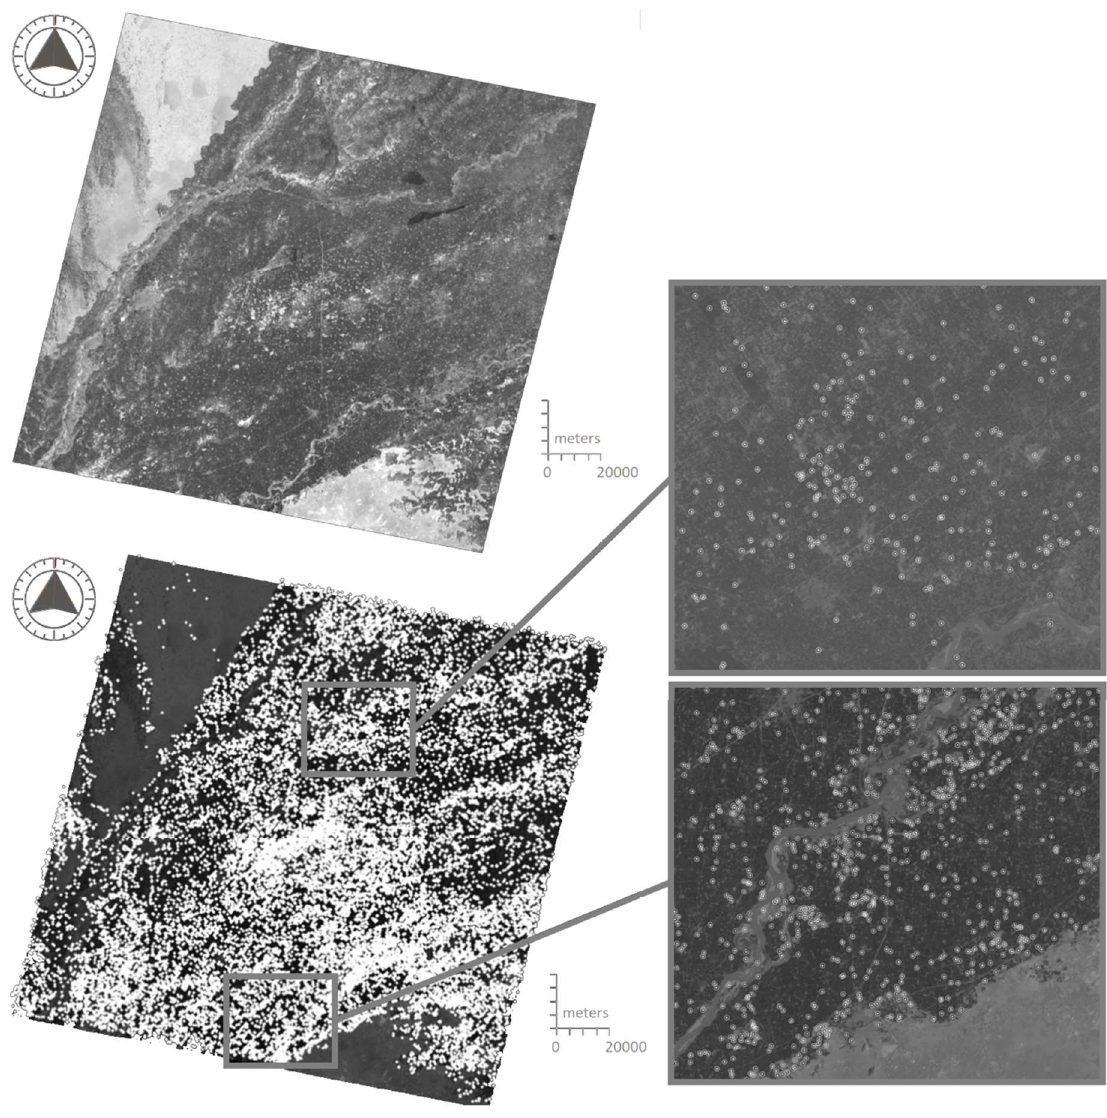
Figure 5. In the upper-left subfigure, the master image (ID8) of ‘Multan’ dataset is shown. In the lower-left subfigure, the same image is overlaid with all the TPs extracted with MIRA procedure. Also, those features that have not been found in the ‘master’ but they connect other images of the same dataset have been re-projected over the master. The two zoom-in windows on the right side display some details of the extracted features in two specific areas.